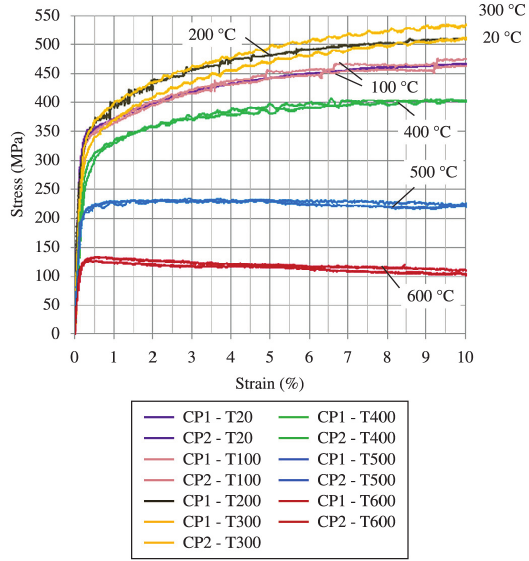
Figure 6. Stress-strain-temperature curves, with deformation ranging from 0 to